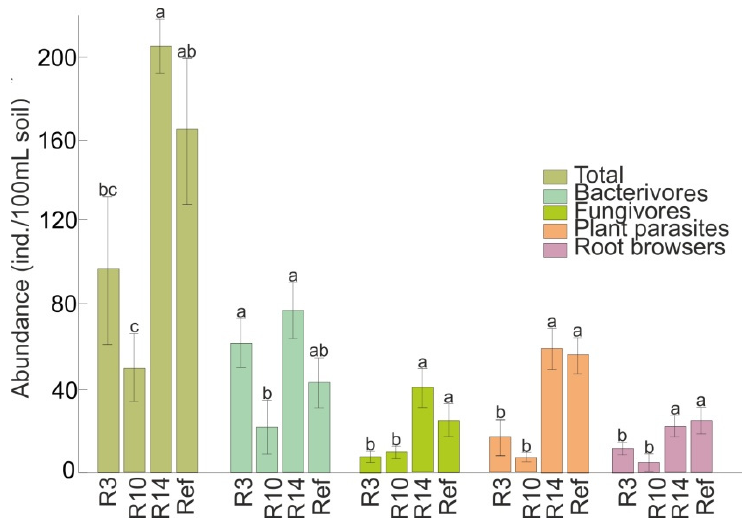
Figure 2. Abundance of different nematode trophic groups in relation to reclamation age. Different letters are used to depict significant differences between sites according to an LSD test.